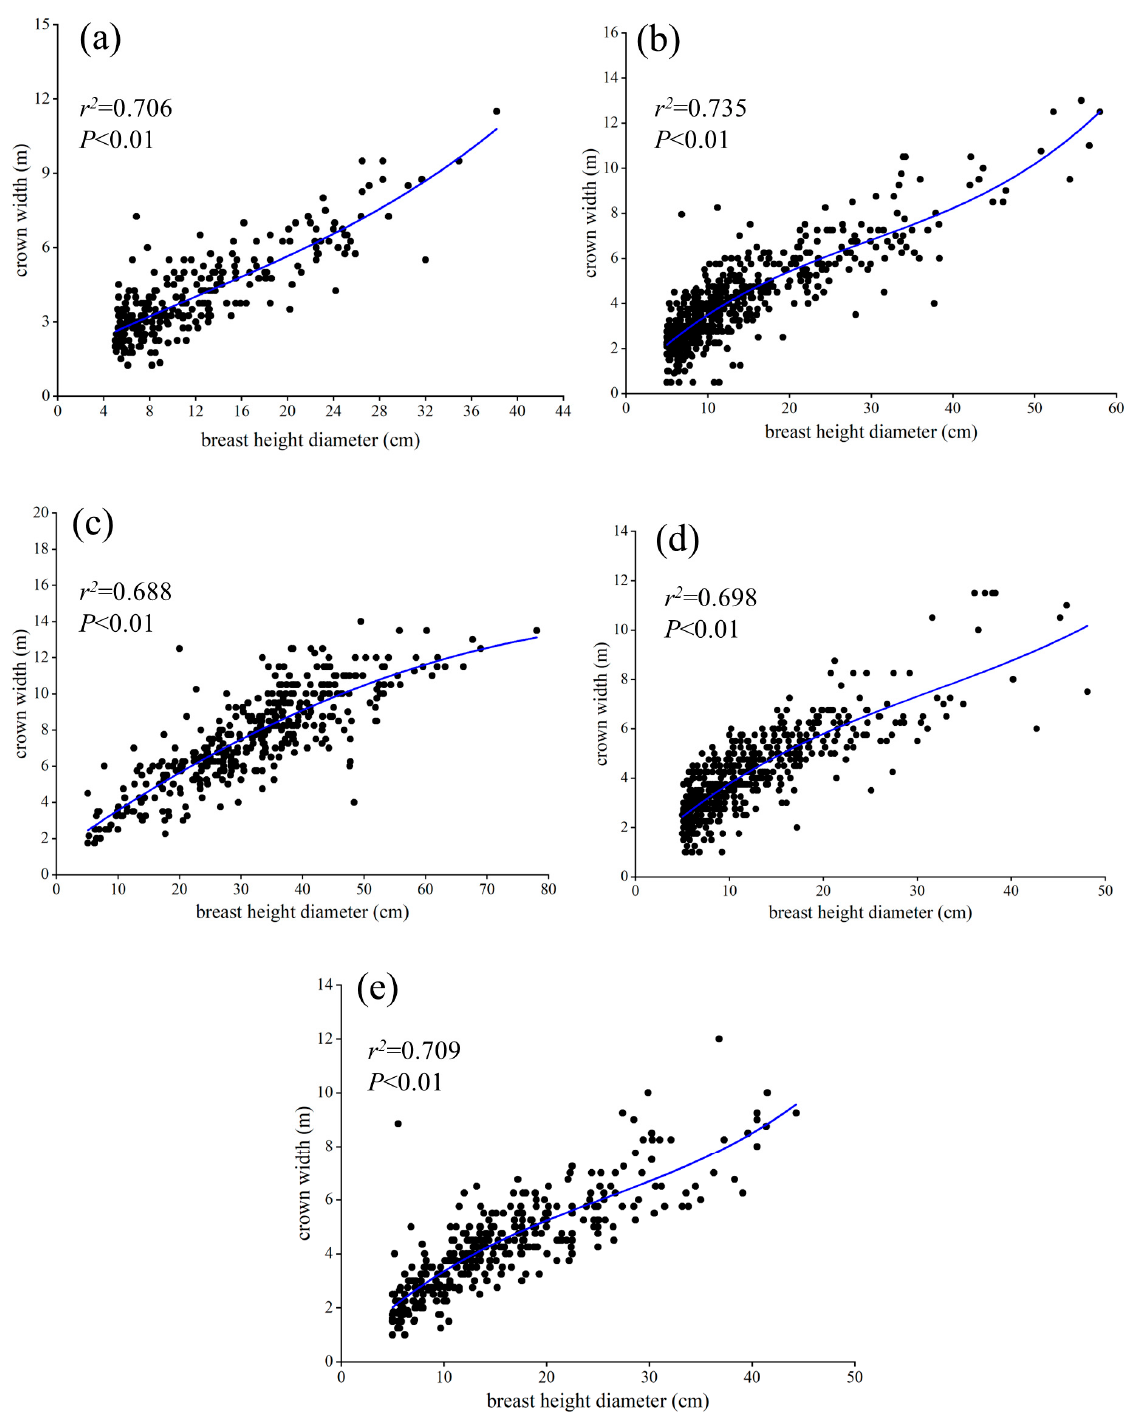
Figure 4. Scatterplot of DBH and crown width. The lines in ( a – e ) represent the optimal curve fitting between DBH and crown width of the main dominant species. ( a ) Acer mandshuricum ; ( b ) Ulmus japonica ; ( c ) Juglans mandshurica ; ( d ) Acer mono ; ( e ) Tilia amurensis .